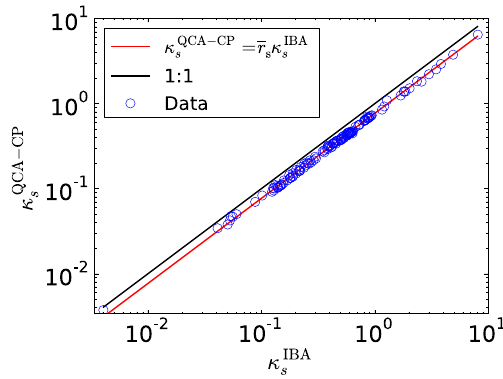
Figure 10. Scatter plot of the scattering coefficient of IBA and QCA-CP from Eqs. (28) and (22), respectively, evaluated for the optimal SHS parameters ( ˆ τ , ˆ d ) retrieved from the µ CT images.